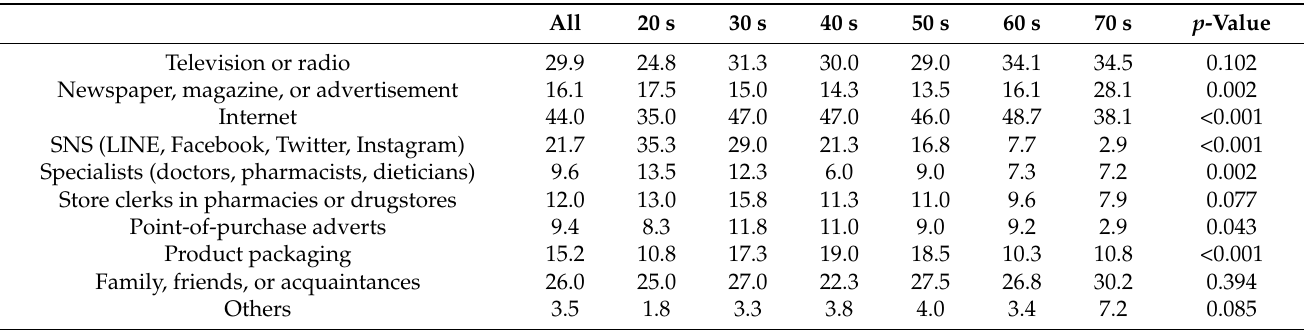
Table 9. Information sources that prompted the participants to use dietary supplements for the prevention of SARS-CoV-2 infection.